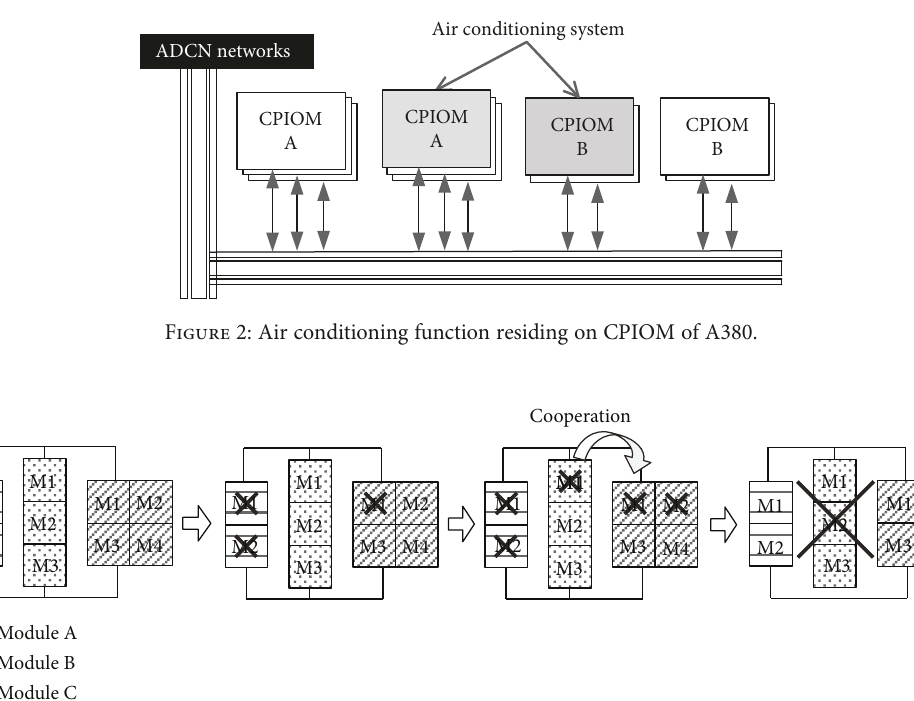
Figure 3: Process of IMA system recon fi